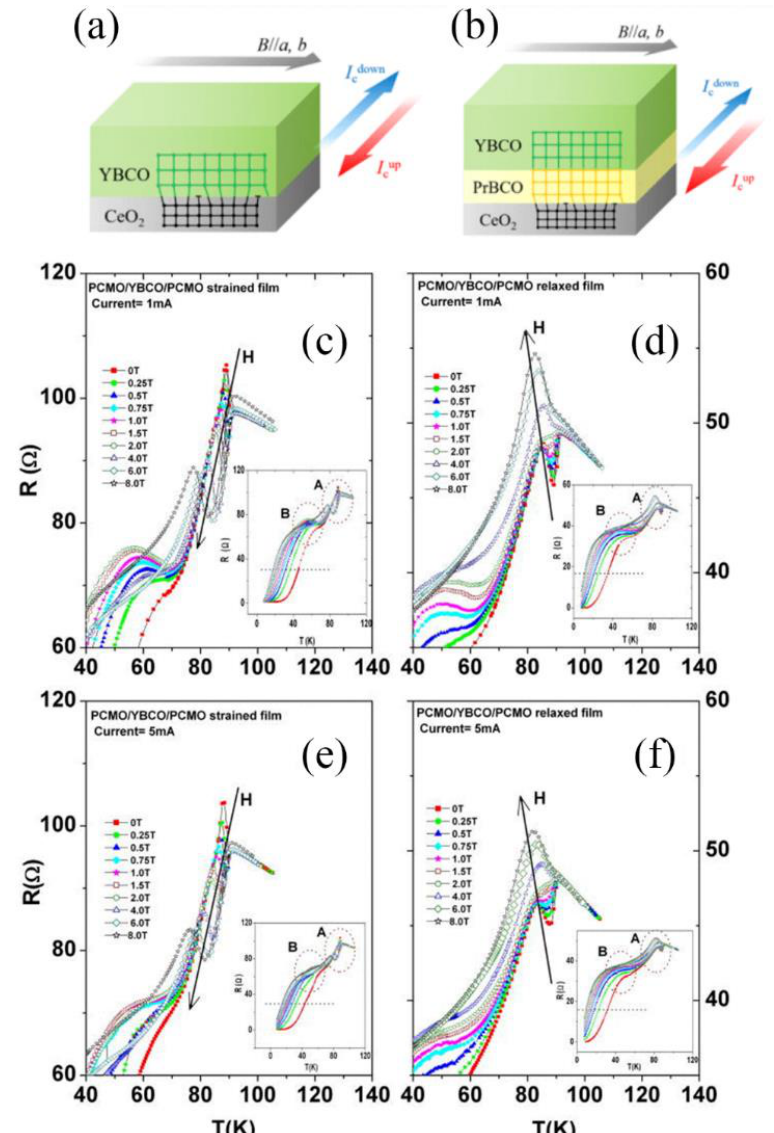
Figure 12. Schematic diagram of ( a ) YBCO and ( b ) YBCO/PrBCO films. Reprinted with permission from Ref. [97]. Copyright 2022, IEEE-Inst Electrical Electronics Engineers Inc. T − R behavior near the hump region at different applied H (0–8 T) for strained films ( c ) and relaxed films ( d ) at 1 mA applied current. ( e ) Strained film and ( f ) relaxed film at 5 mA applied current. Reprinted with permission from Ref. [98]. Copyright 2013, AIP Publishing. Dipak Kumar Baisnab et al. [98] deposited trilayer films of Pr 0.5 Ca 0.5 MnO 3 /YBCO/Pr 0.5 Ca 0.5 MnO 3 on MgO substrates by PLD. In one trilayer, the bot- tom Pr 0.5 Ca 0.5 MnO 3 layer was thin, and thus, subjected to strain induced by strain. How- ever, in another trilayer, the bottom layer was thick enough to prevent such strain from occurring. To explore how charge − order melting and the formation of ferromagnetic clus- ters in Pr 0.5 Ca 0.5 MnO 3 films influence the superconductivity of YBCO, current and mag- netic field-dependent resistance measurements were carried out on the trilayers at liquid helium temperatures. Compared with other trilayers, the suppression of strain on T c of YBCO was relatively high. Based on the above data, the activation energy of vortex hop- ping in the sandwiched YBCO film was evaluated. The strained trilayer showed higher